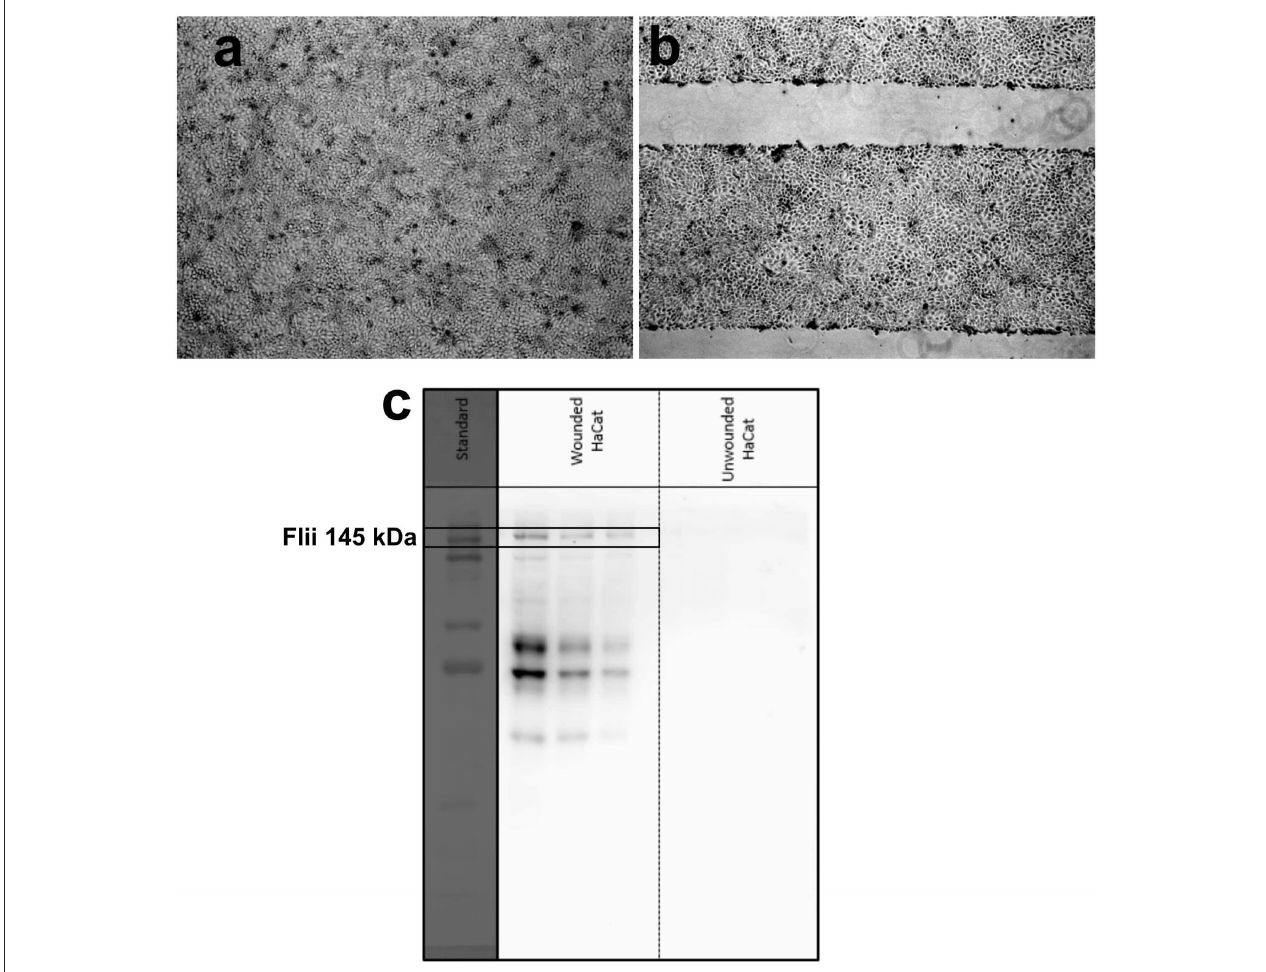
FIGURE 4 | Brightfield microscopy images of (a) unwounded and (b) wounded HaCat cells at confluency (lines without cells in (b) correspond to deliberately induced scratches in the confluent HaCat cells); (c) Western blot for three dilutions (from left: 1.0X, 0.6X, and 0.2X) of media collected from wounded and unwounded